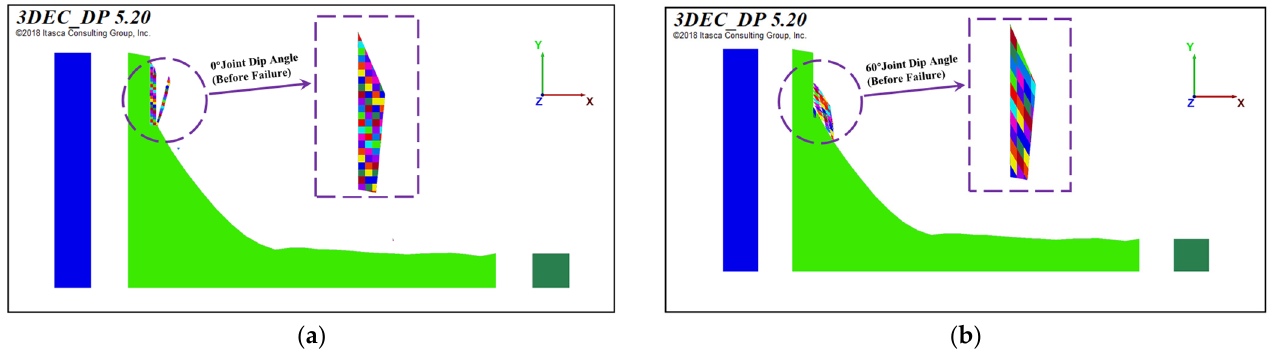
Figure 21. Failure behavior of the rock slide with joints dip angle 0° ( a ) and 60° ( b ) under three ‐ directional seismic wave.